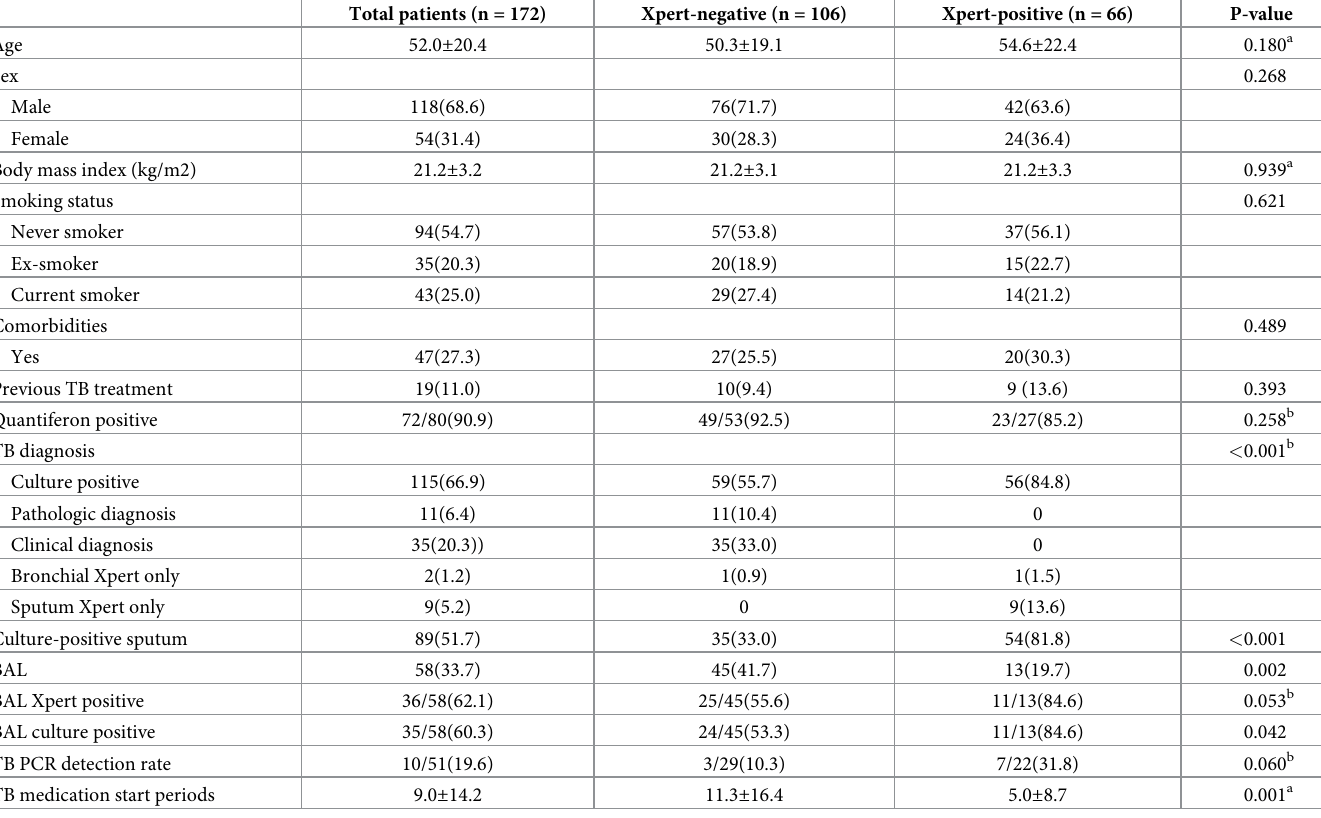
Table 2. Clinical characteristics of patients with Xpert MTB/RIF positive and